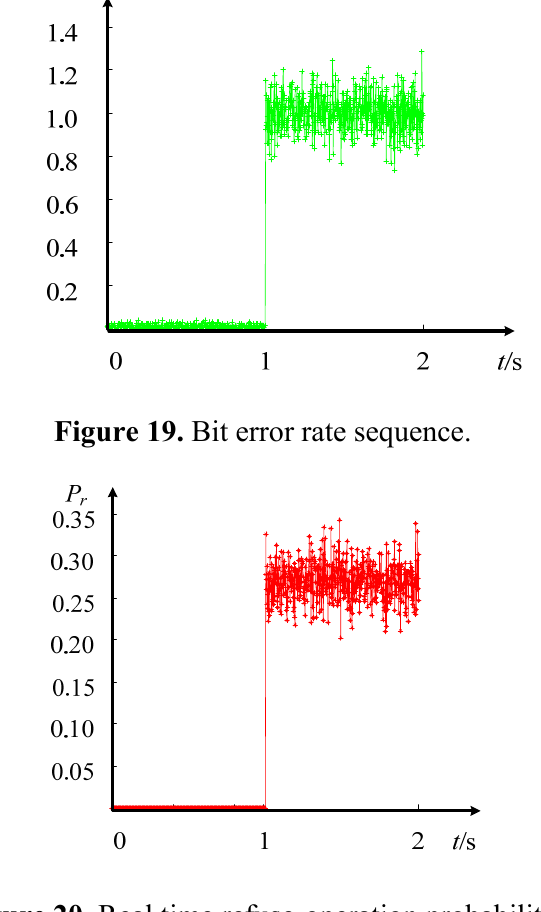
Figure 20. Real time refuse-operation